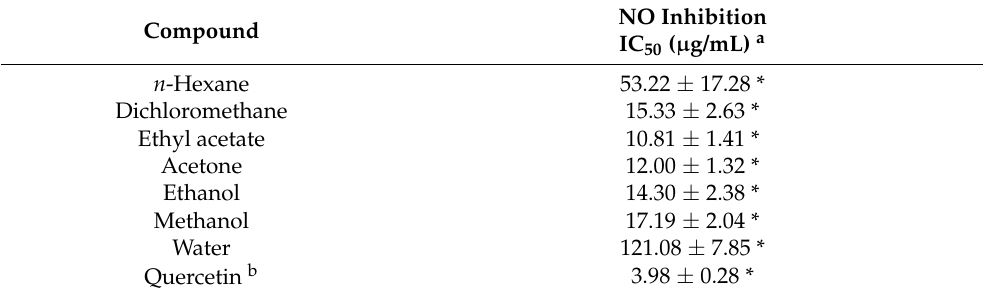
Table 4. The effects of solvent extracts on nitric oxide (NO) production in RAW 264.7 cells.